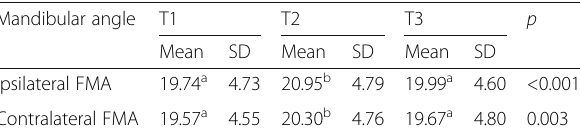
Different superscript letters show statistically significant differences FMA mandibular plane angle, T1 preoperatively, T2 immediately after expansion, T3 6 months after expansion, SD standard